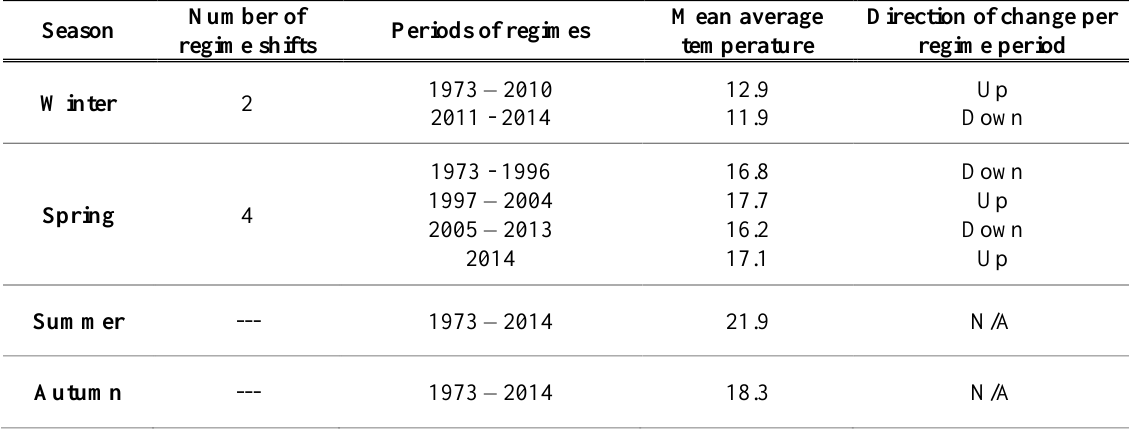
Table A4.2: Regime shifts according to seasons (tri-month average temperature) for